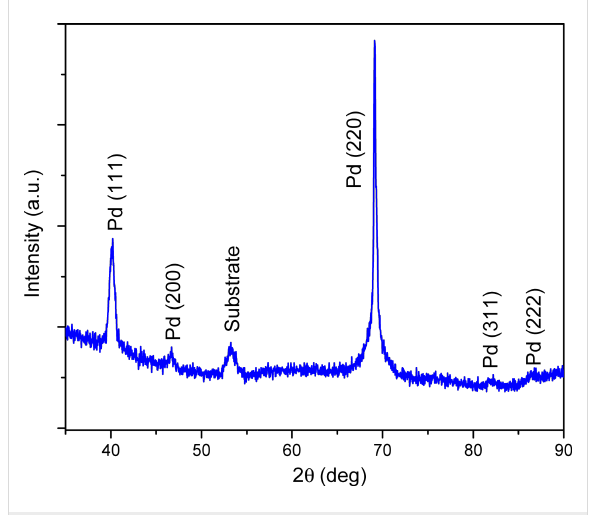
Figure 10: X-ray diffractogram of Pd deposited by ALD exhibiting a polycrystalline structure with a preferential orientation along the fcc [220] direction.